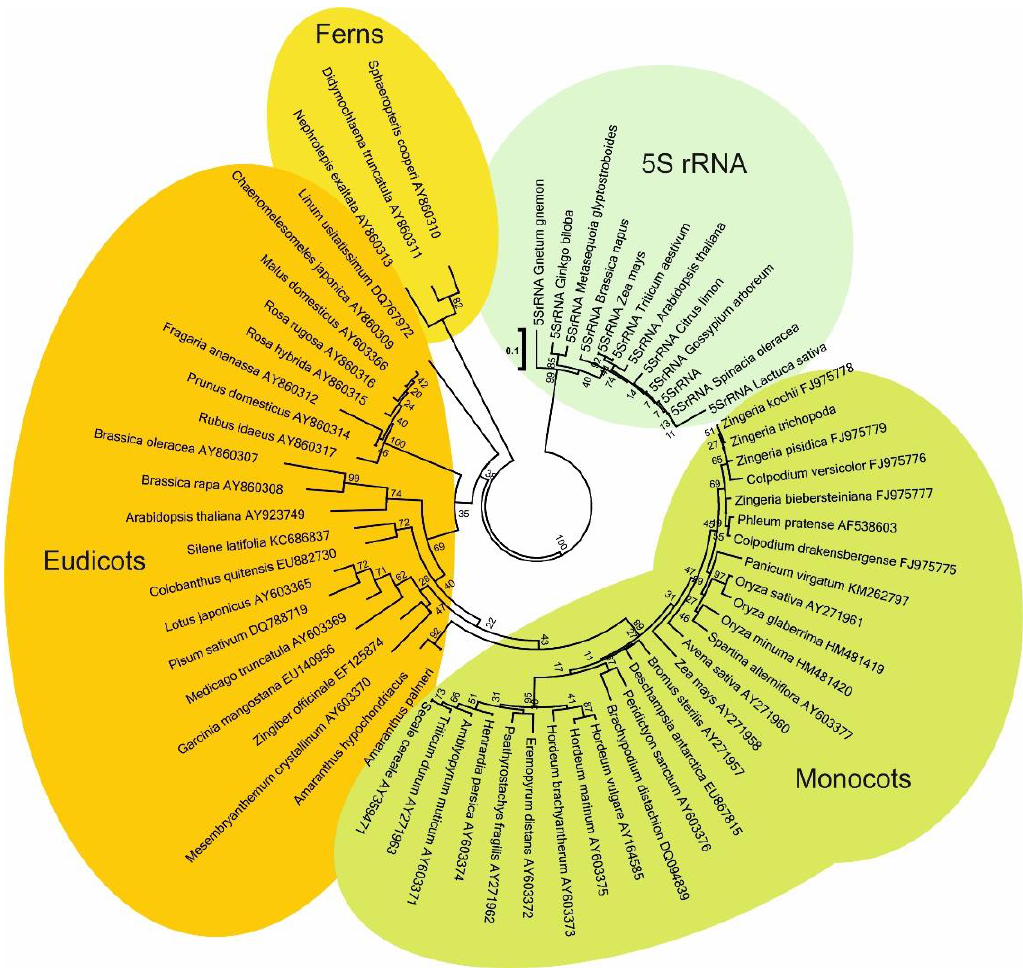
Figure 4. Phylogenetic relationships among Cassandra elements by neighbor joining. A maximum likelihood tree with all sequenced Cassandras is topologically similar.